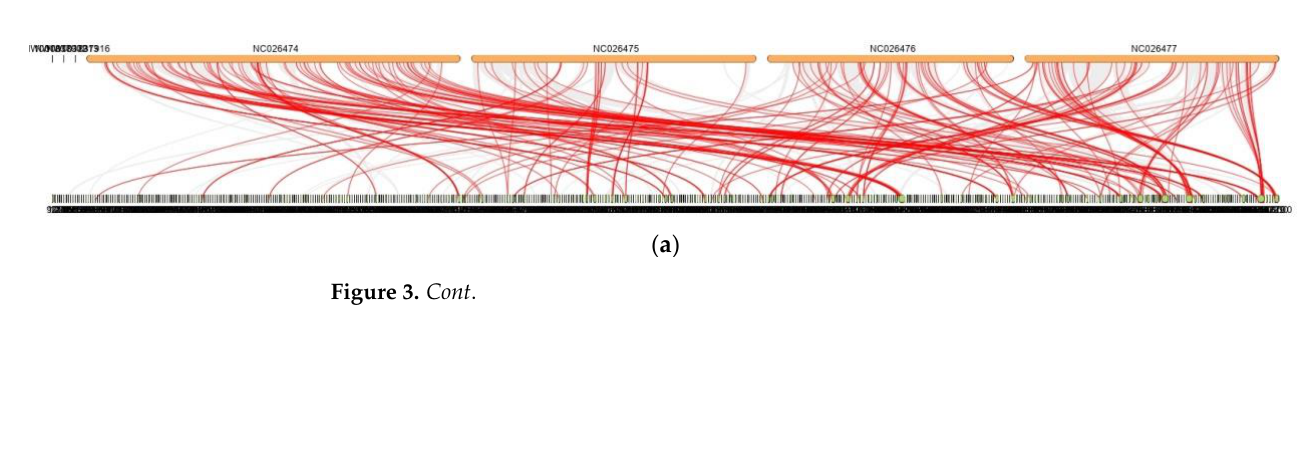
Figure 2. Ci 14017 gene functions categories. ( a ) GO classification statistics of Ci 14017. Blast2GO (http://www.geneontology.org/), accessed on 28 April 2022 for GO term annotation; ( b ) KOG classification statistics of Ci 14017. KOG (http://ww.ncbi.nlm.nih.gov/KOG/), accessed on 28 April 2022; and ( c ) gene statistics of KEGG pathway in Ci 14017. KEGG pathway mapping (http://www.genome.jp/kegg/), accessed on 28 April 2022.